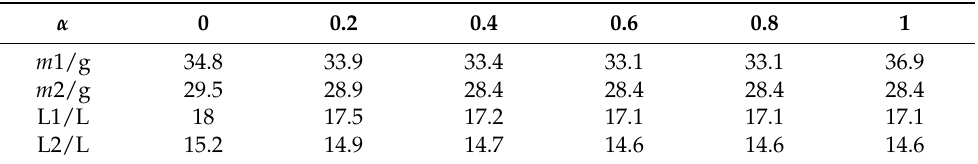
Table 10. Energy consumption table corresponding to the compensable coefficients of different motors underworking condition B in bench